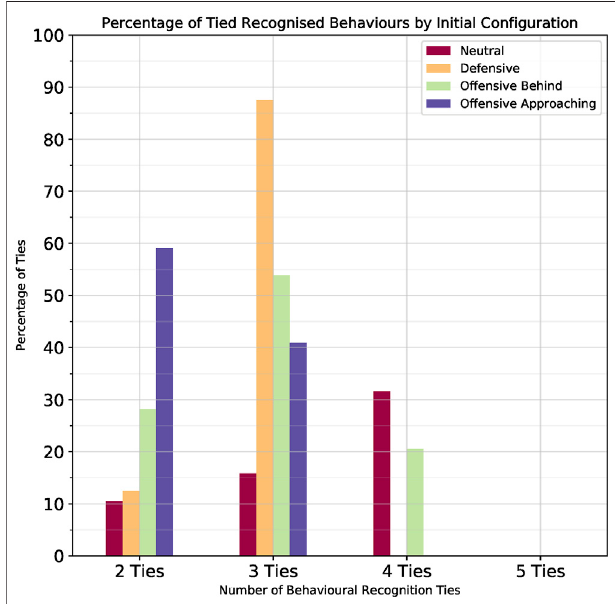
FIGURE11| Percentoftiesbetweenbehavioursperinitialcon fi guration.